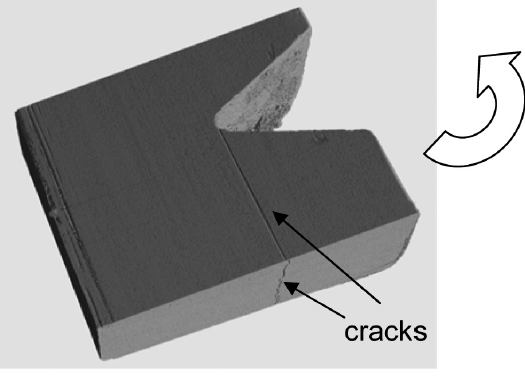
Fig. 6. Damaged bottom area or region of interest and arrow indicating how the view was rotated in order to emphasise at the whole crack distribution.